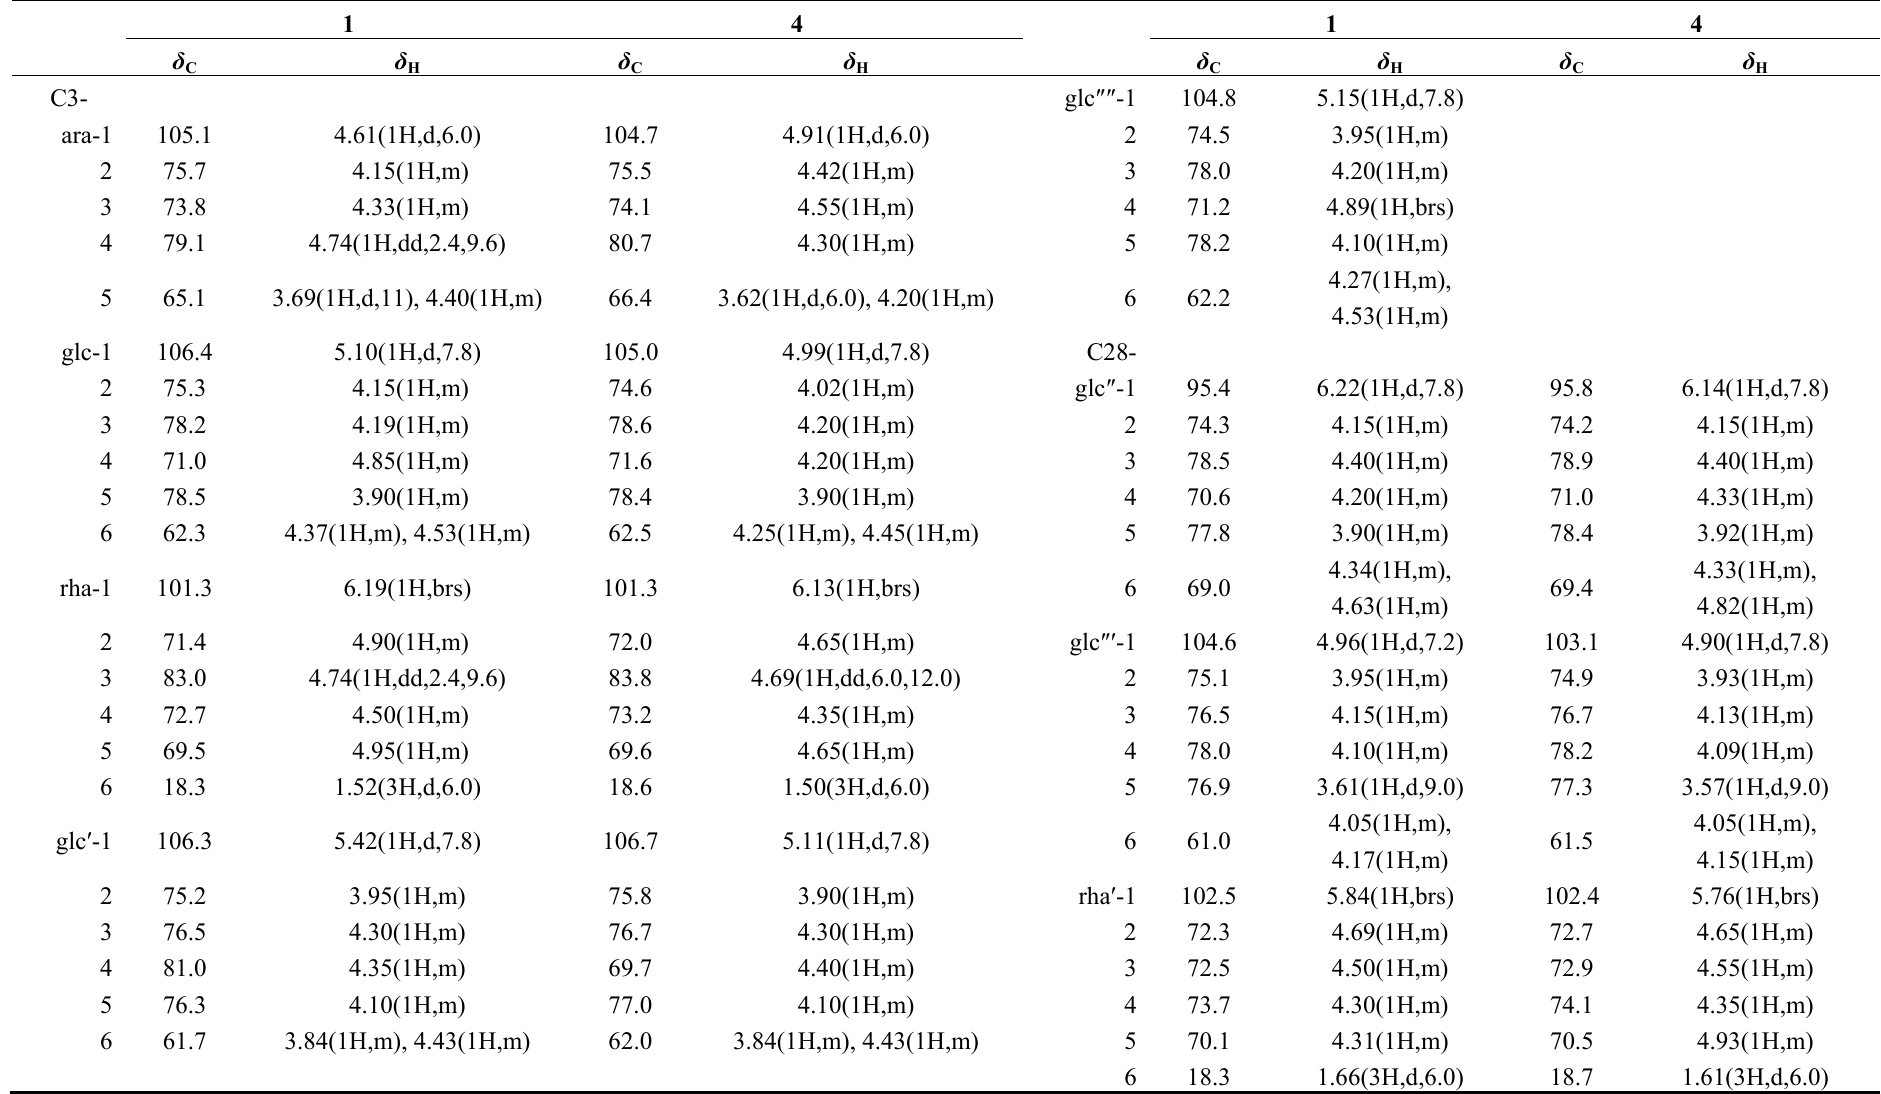
Table 1. Spectroscopic data of 1 and 4 (sugar moieties, δ in ppm, J in Hz) in pyridine- d